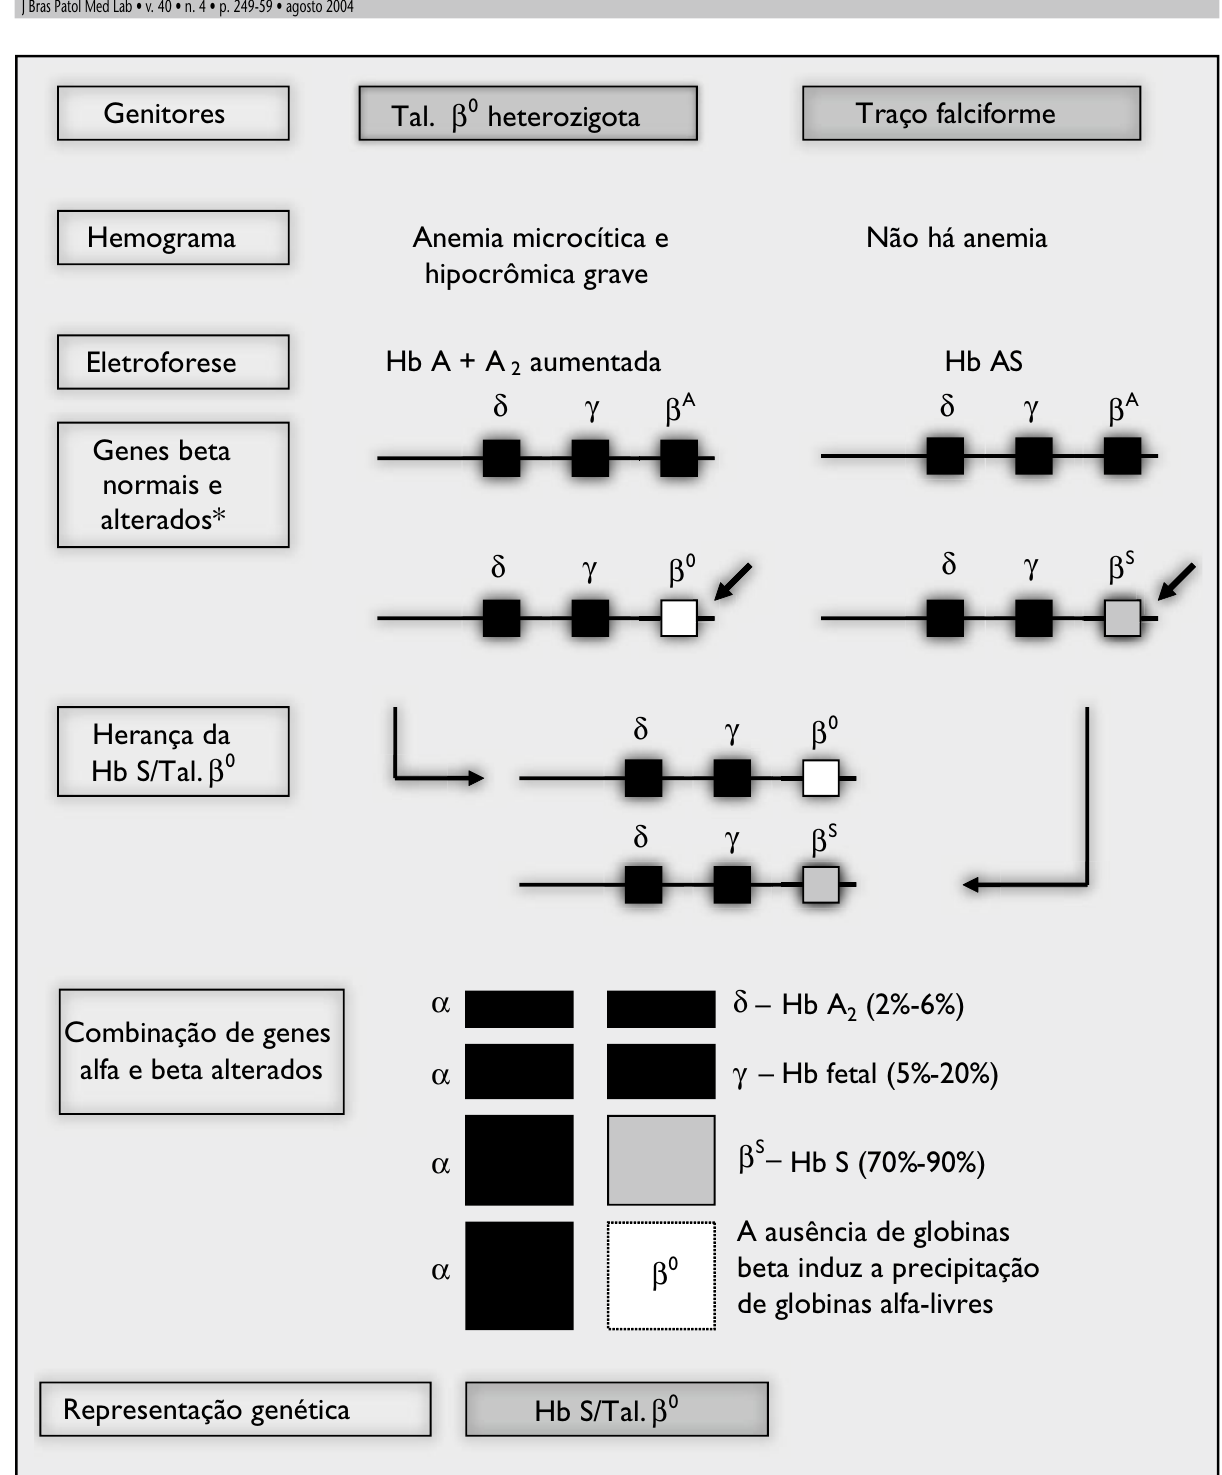
Figura 3 – Representação esquemática da herança e das conseqüências fi siopatológicas da Hb S/Tal. β